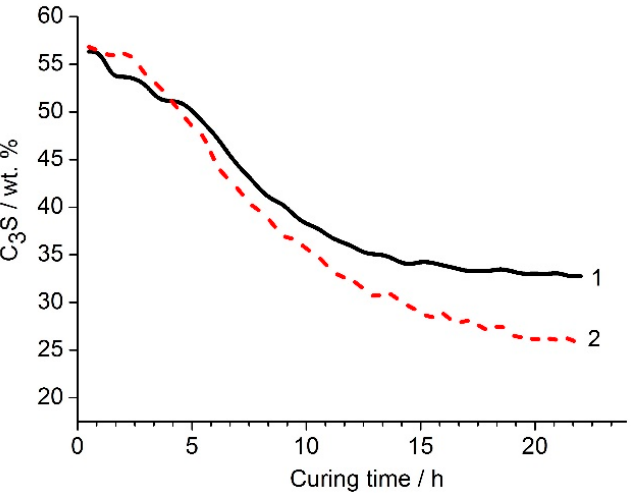
Figure 6. Variation of the alite (C 3 S) content in the paste as a function of curing time: PC (1) and PC–NC blend (2).